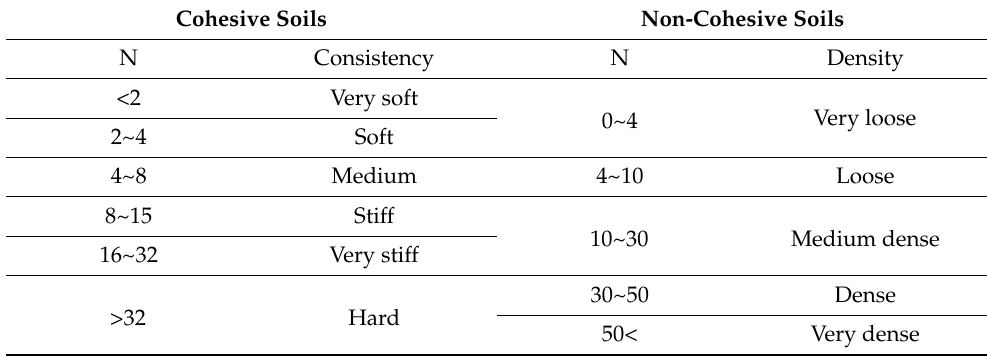
Table 2. Density and consistency of soil derived from standard penetration testing [22].